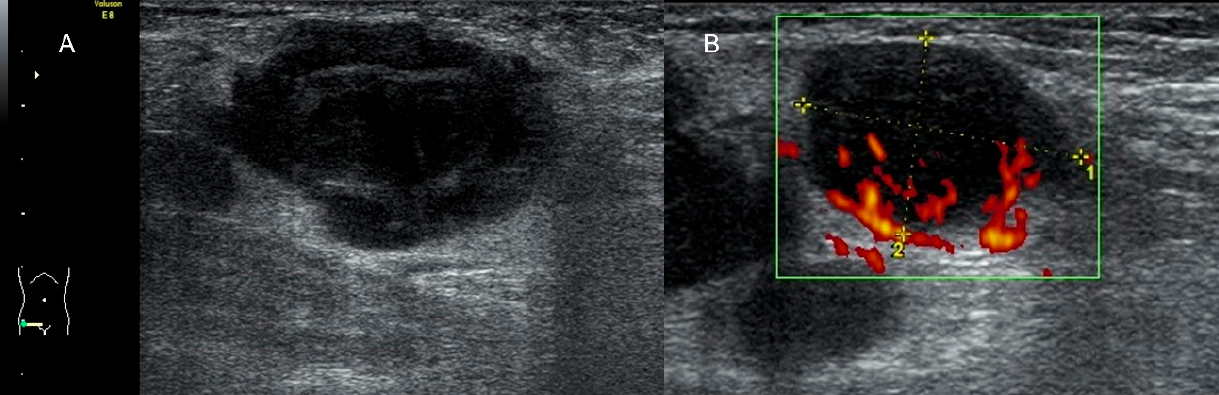
Figure 23. Soft-tissue ultrasound demonstrates an irregular hypoechoic nodule ( A ) in which power Doppler demonstrates abundant penetrating vascularization ( B ). Both Figures 22 and 23 depict lymphoma. Lymphocele is a collection of lymphatic liquid inside a thick, fibrous, non-epithelial wall and with no vascularization, arising from the retroperitoneum to the pelvic or abdom- inal cavity. Ultrasound shows lymphocele as an oval, round, or hourglass-shaped, and uni- or multilocular tumor with a thick wall. The contained fluid may be anechoic, low- level, ground-glass, hemorrhagic, or mixed echogenicity. It may present with intraluminal septations or debris (Figure 24) [29].